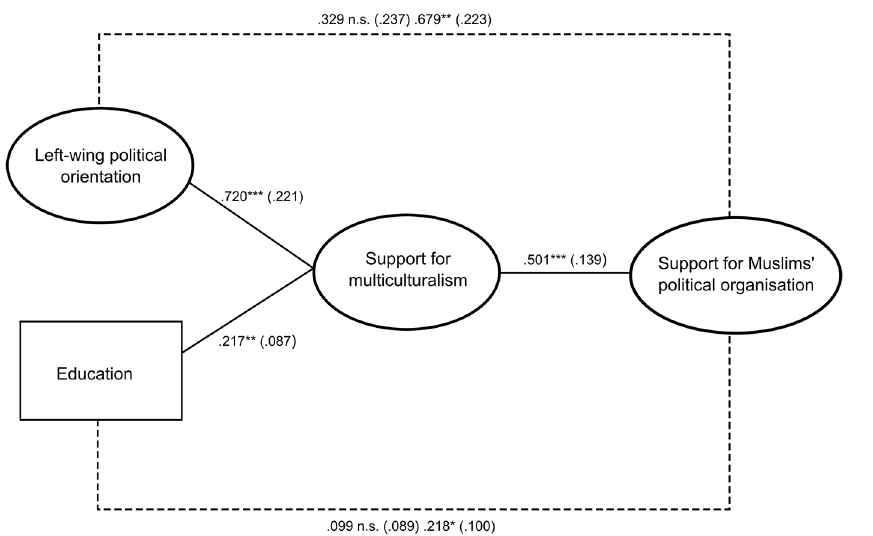
Figure 1. Associations between political orientation, education, endorsement of multiculturalism and support for Muslim’s political organisation (Study